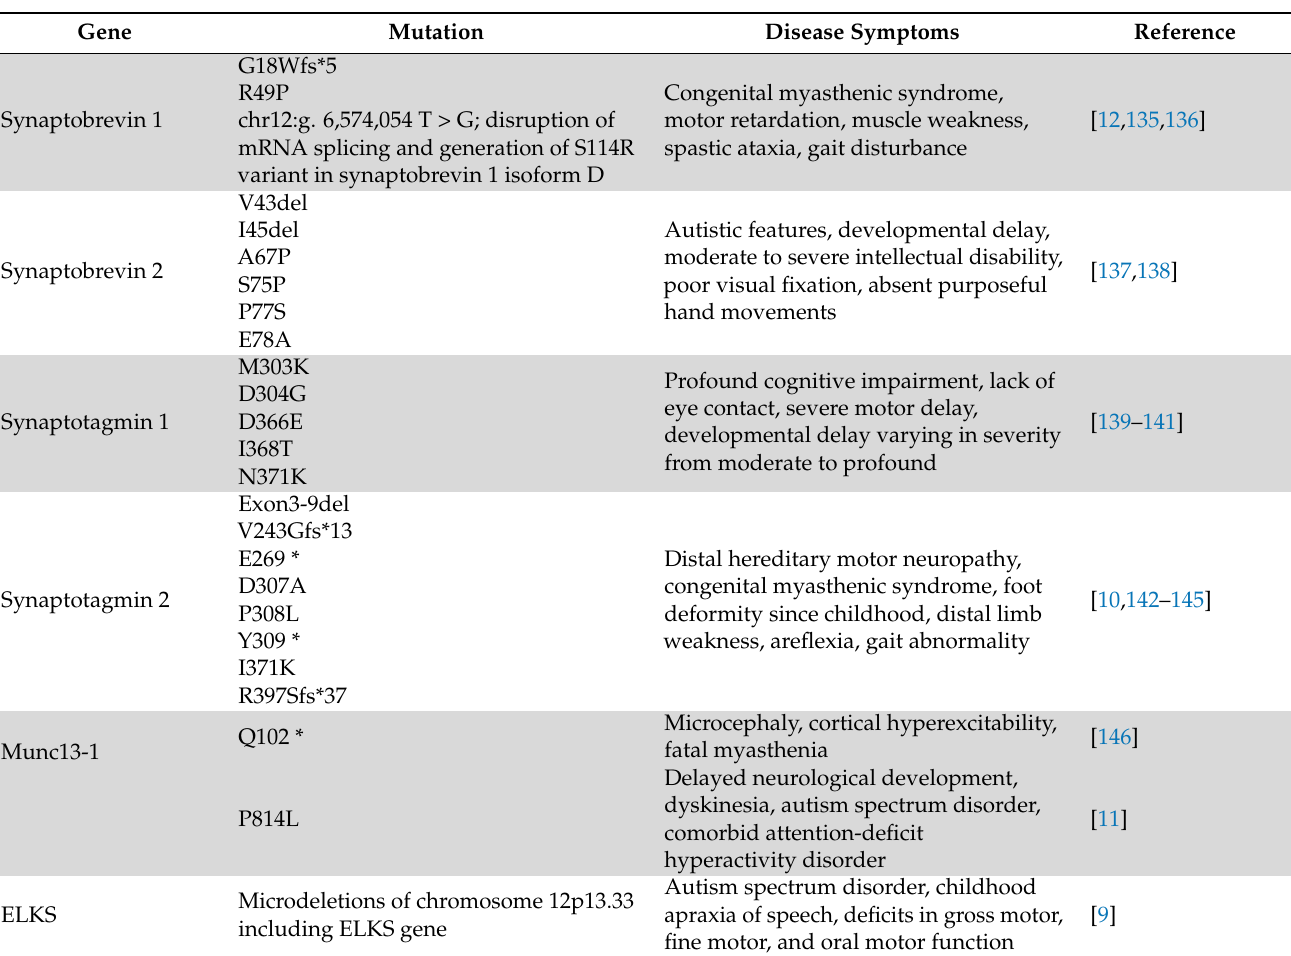
Table 3. Relationship between genetic alterations in exocytosis-related proteins and neurological disease